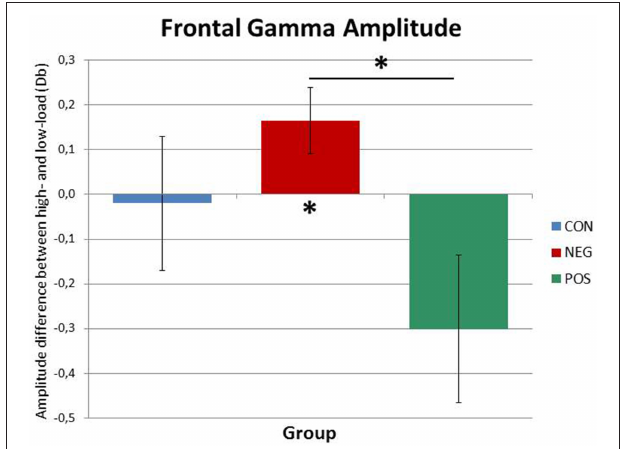
FIGURE 3 | Frontal gamma amplitude differences between high-load and low-load conditions for the three groups. While the positive symptomatic group shows decreased gamma power in the ACC in the high-load condition, the negative symptomatic group displays a marked increase. The healthy control subjects do not differ from either patient group. Significant differences are indicated by asterisks ( p < 0.05